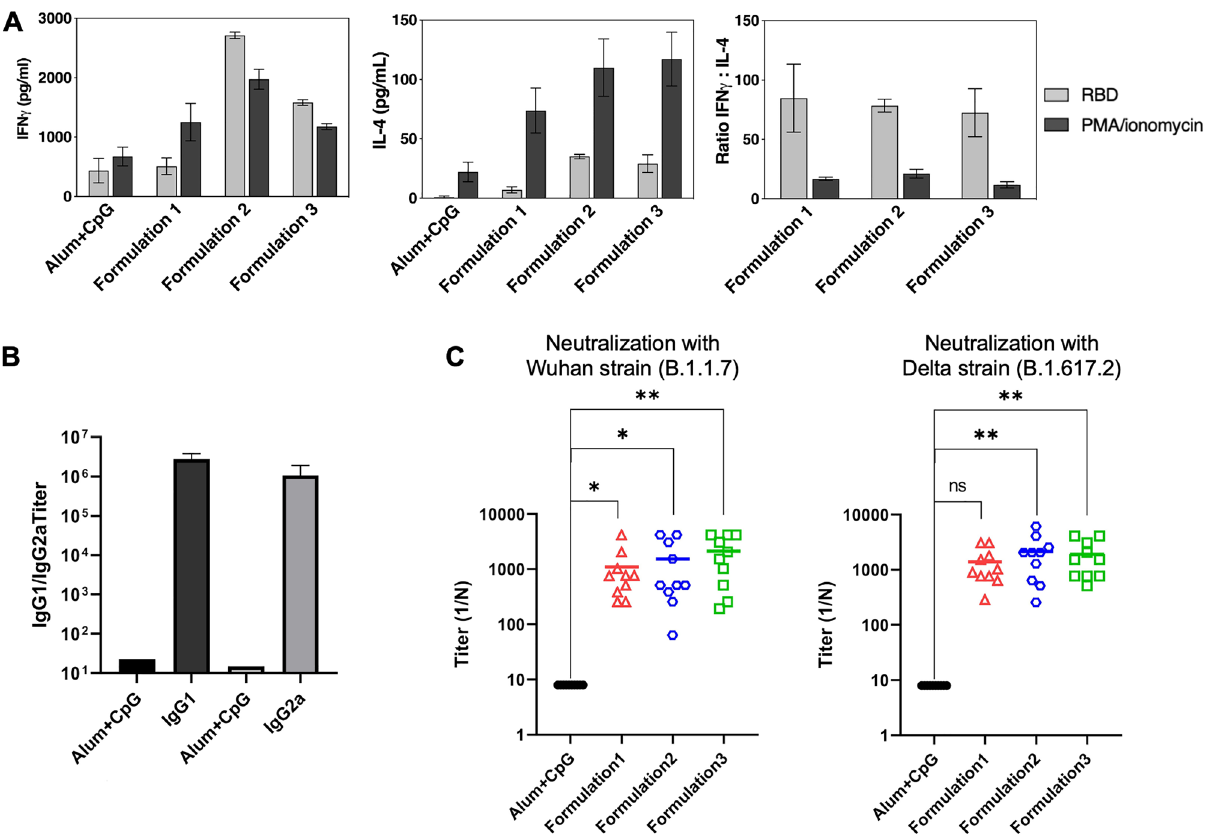
Figure 5. T cell response, IgG subtype and neutralization studies for the RBD-DP vaccine. ( A ) Splenocytes from mice (n = 5) of the indicated groups were stimulated with either RBD-DP (RBD, 24 h) or PMA/ionomycin (4 h) and the cytokine concentration in the supernatant was determined by ELISA. IFNγ (left panel) and IL-4 (middle panel) concentration and the IFNγ/IL-4 ratio (right panel). Representative data from at least two independent experiments are shown. ( B ) Titers of IgG1 and IgG2a subtypes in mice after immunized with formulation 2. ( C ) Live virus neutralization assay with two different strains of SARS-CoV-2 for mice immunized three doses with formulation 2. Formulation 1: 25 µg RBD-DP, 600 µg Alum, 30 µg CpG, Formulation 2: 10 µg RBD-DP, 100 µg Alum, 30 µg CpG, Formulation 3: 25 µg RBD-DP, 100 µg Alum, 30 µg CpG, Alum +